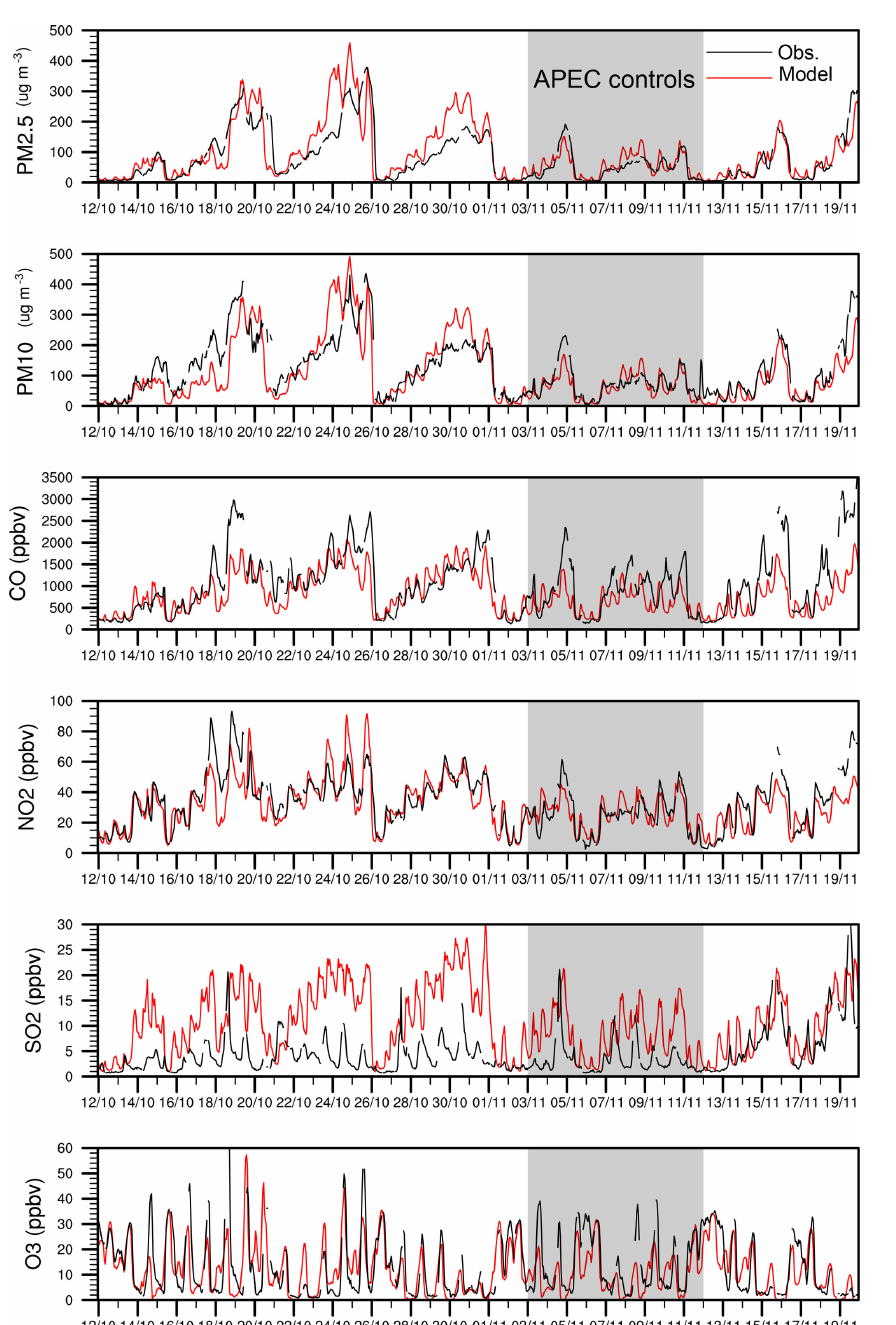
Figure 4. Mean time series of surface pollutants over the 12 air quality stations in Beijing. Model values are with baseline emissions at all times, including during the APEC period